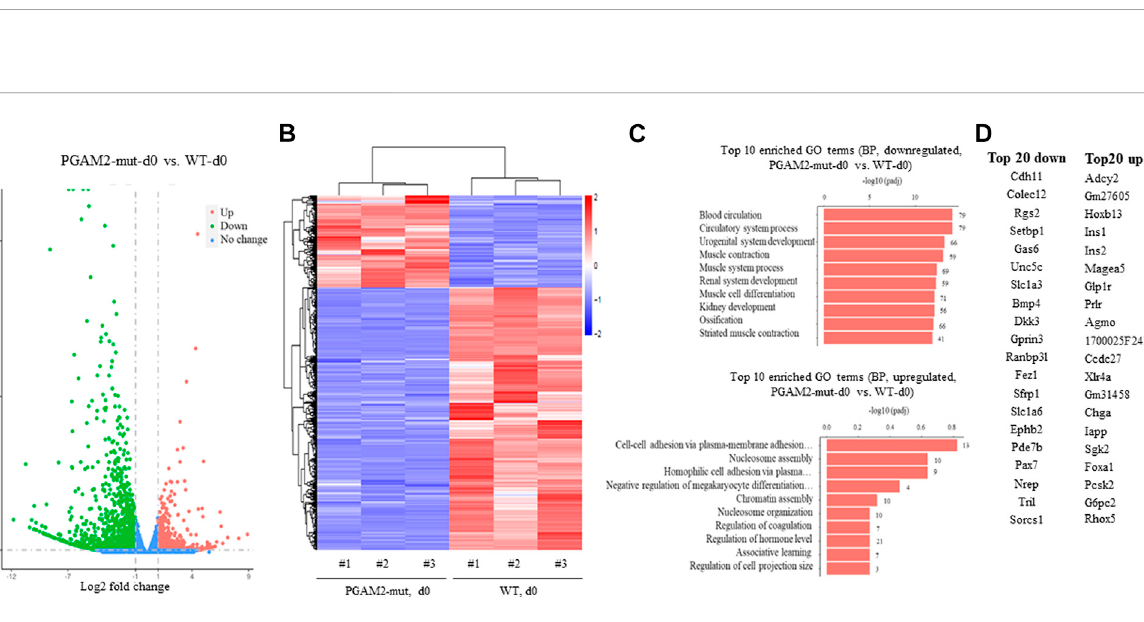
FIGURE 6 Dysregulated gene expression in PGAM2-K176R mutant C2C12 cells at differentiation day 0. Results of RNA sequencing analysis of WT and PGAM2-K176R mutant C2C12 cells at differentiation day (d)0. (A) Volcano plot with a fi lter of padj < 0.05 and a |log2 fold change| = 1 shows the changes in differentially expressed genes (DEGs) in WT and PGAM2-K176R mutant C2C12 cells. (B) Heatmap providing a global view of DEGs in WT and PGAM2-K176R mutant cells. (C) Top 10 most enriched GO terms in the biological pathways (BPs) associated with downregulated (top panel)andupregulated(bottompanel)genesinPGAM2-K176RmutantcellscomparedwithWTcells. (D) Top20mostdownregulated(leftpanel)and upregulated (right panel) genes in PGAM2-K176R mutant cells compared with WT